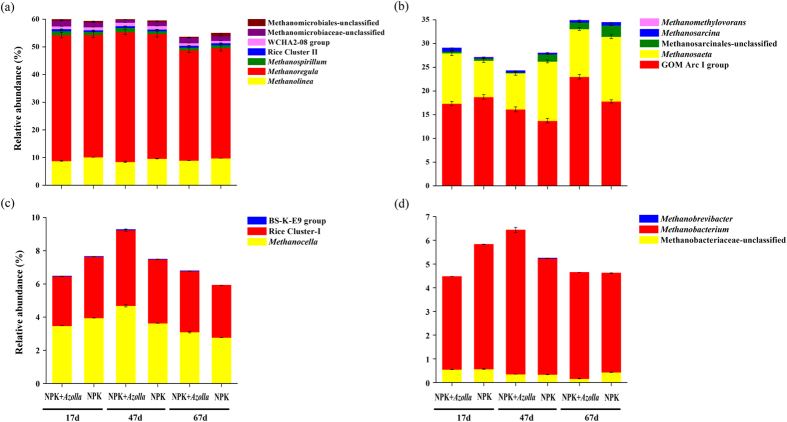
Variations in the communities of Methanomicrobiales (a), Methanosarcinales (b), Methanocellales (c) and Methanobacteriales (d) detected in the paddy soil during the rice cultivation period. Methanogenic archaeal 16S rRNA gene sequencing reads were classified at the genus level using the RDP Classifier (http://rdp.cme.msu.edu/) against the silva (SSU115) 16S rRNA database; only the genera known to be methanogens are shown. NPK, rice cropping without dual cropping of Azolla under recommended fertilization; NPK + Azolla, rice cropping with dual cropping of Azolla under recommended fertilization.